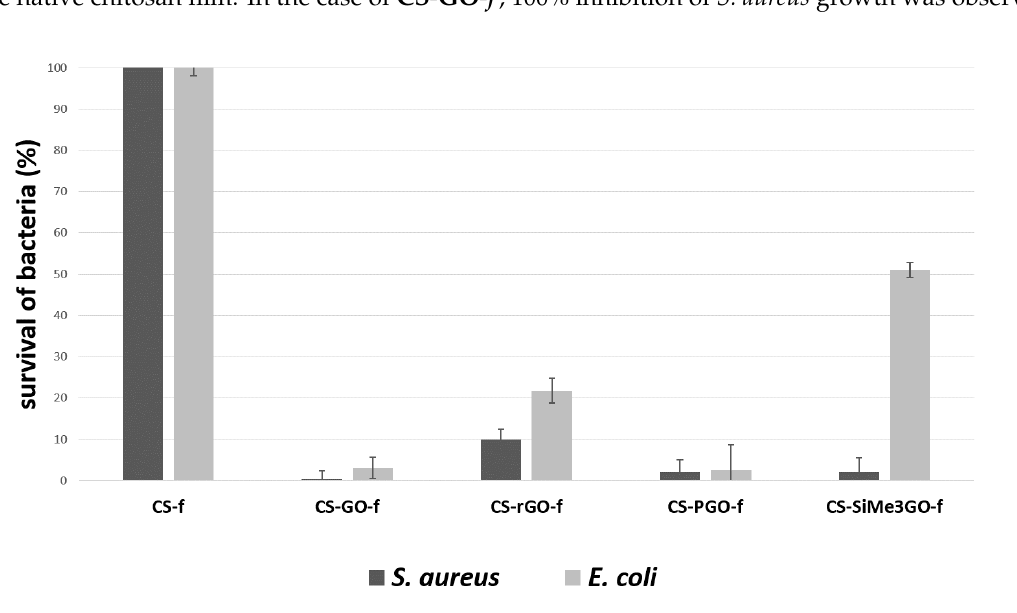
Figure 5. Antibacterial activity of the resulting nanocomposite films; inhibition (%) of S. aureus and E. coli after 24 h